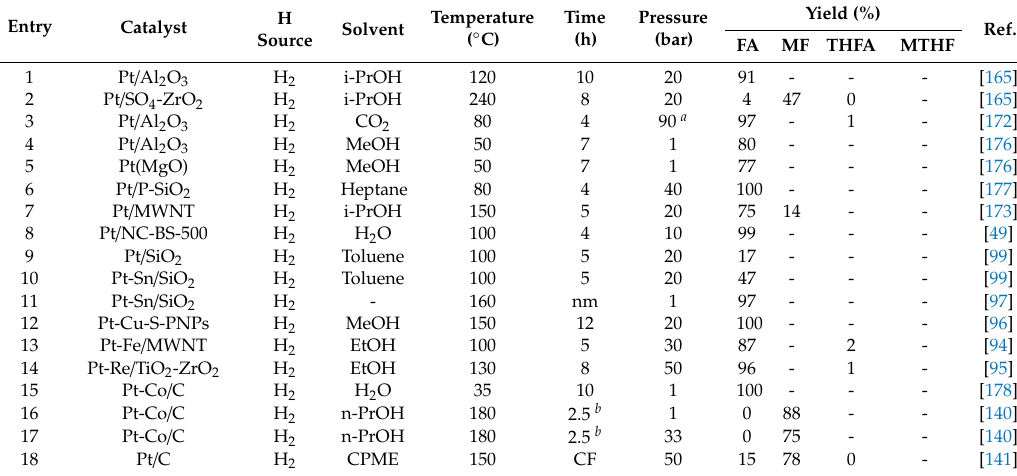
Table 5. Furfural hydrogenation over Pt-based